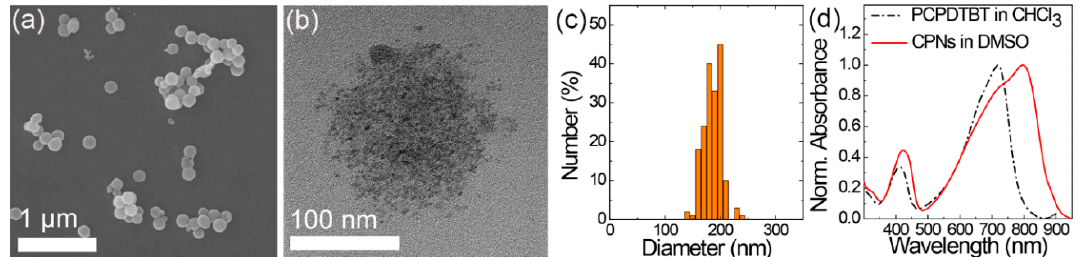
Figure 1. ( a ) SEM and ( b ) TEM images of PCPDTBT nanoparticles assembled with OA at a molar mixing ratio of PCPDTBT to OA of 1:12 and ( c ) particle size distribution. ( d ) Absorption spectra of the PCPDTBT dissolved in CHCl 3 (reproduced from Ref. [26] with permission. Copyright 2018, Elsevier) and assembled into CPNs.